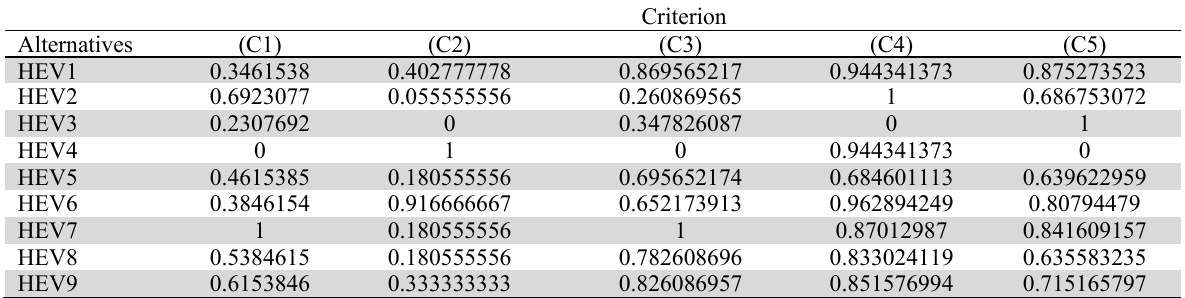
Normalized matrix N